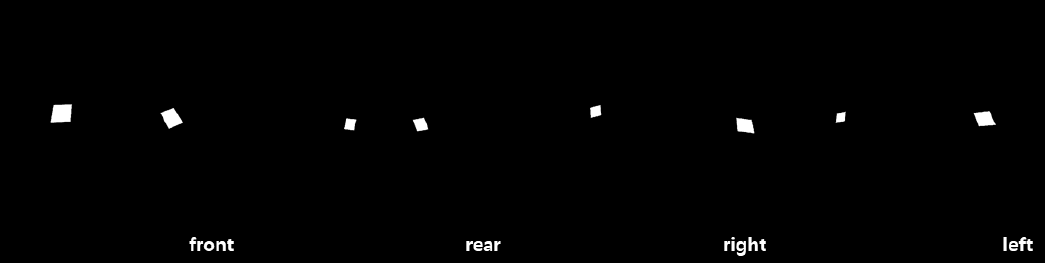
Figure 11. Example images for the performance evaluation of the proposed method.